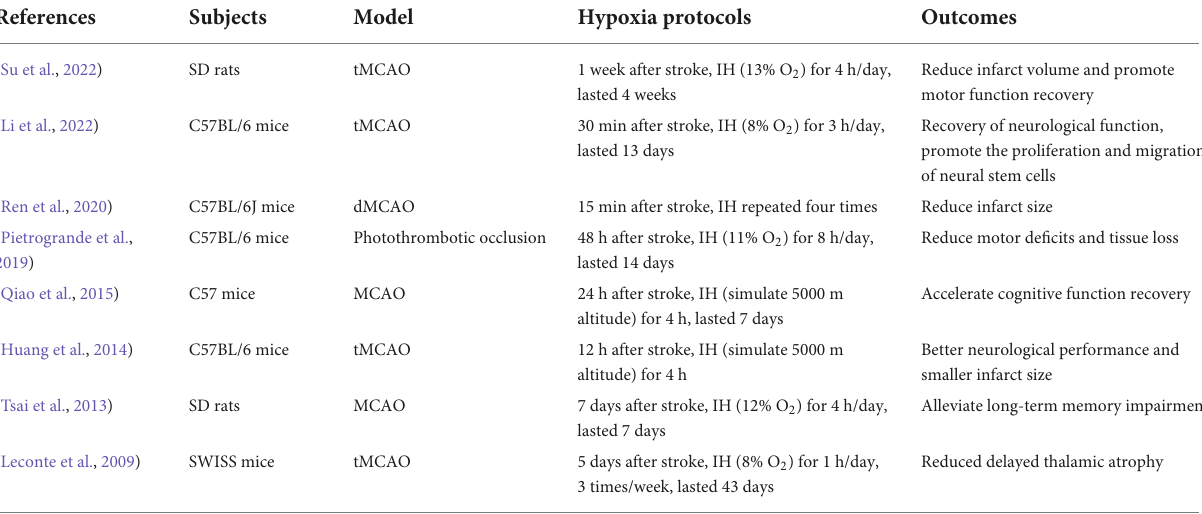
TABLE 4 Beneficial effects of intermittent hypoxia postconditioning in ischemic